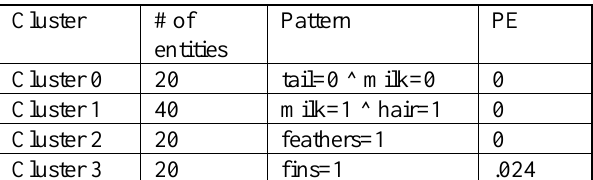
Table 5: Characteristics of animal